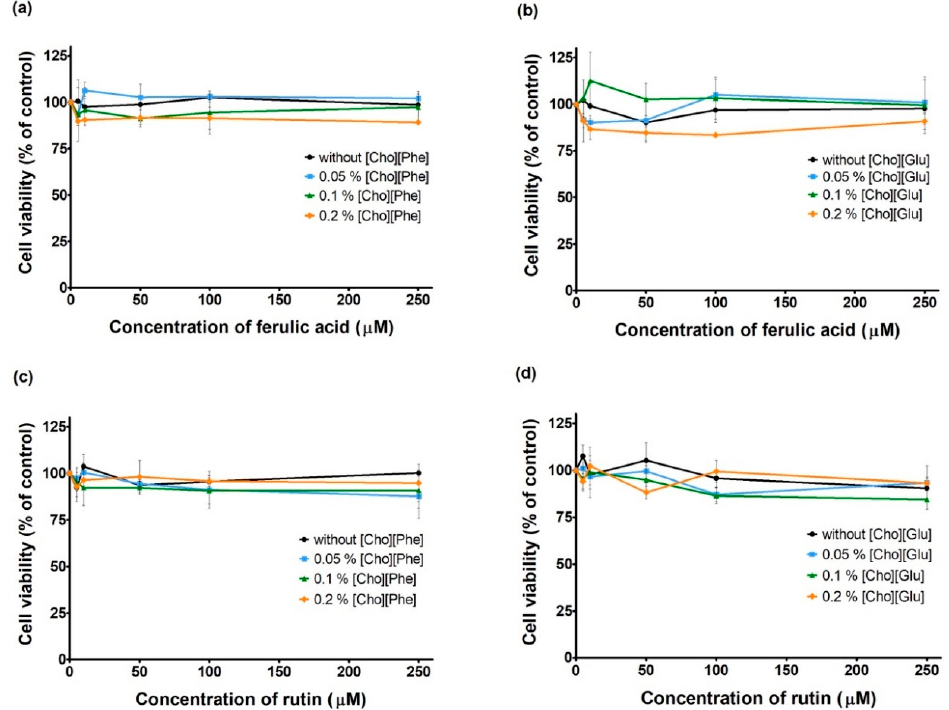
Figure 4. Cell viability of MDA-MB-231 cells exposed to ferulic acid and [Cho][Phe] ( a ) or [Cho][Glu] ( b ) and rutin and [Cho][Phe] ( c ) or [Glu] ( d ). The cell viability of active:IL mixture-exposed cells (48 h) was evaluated by CV assay. Values represent mean ± SD (n = 2–3) and are expressed as percentages of the non-treated control cells.